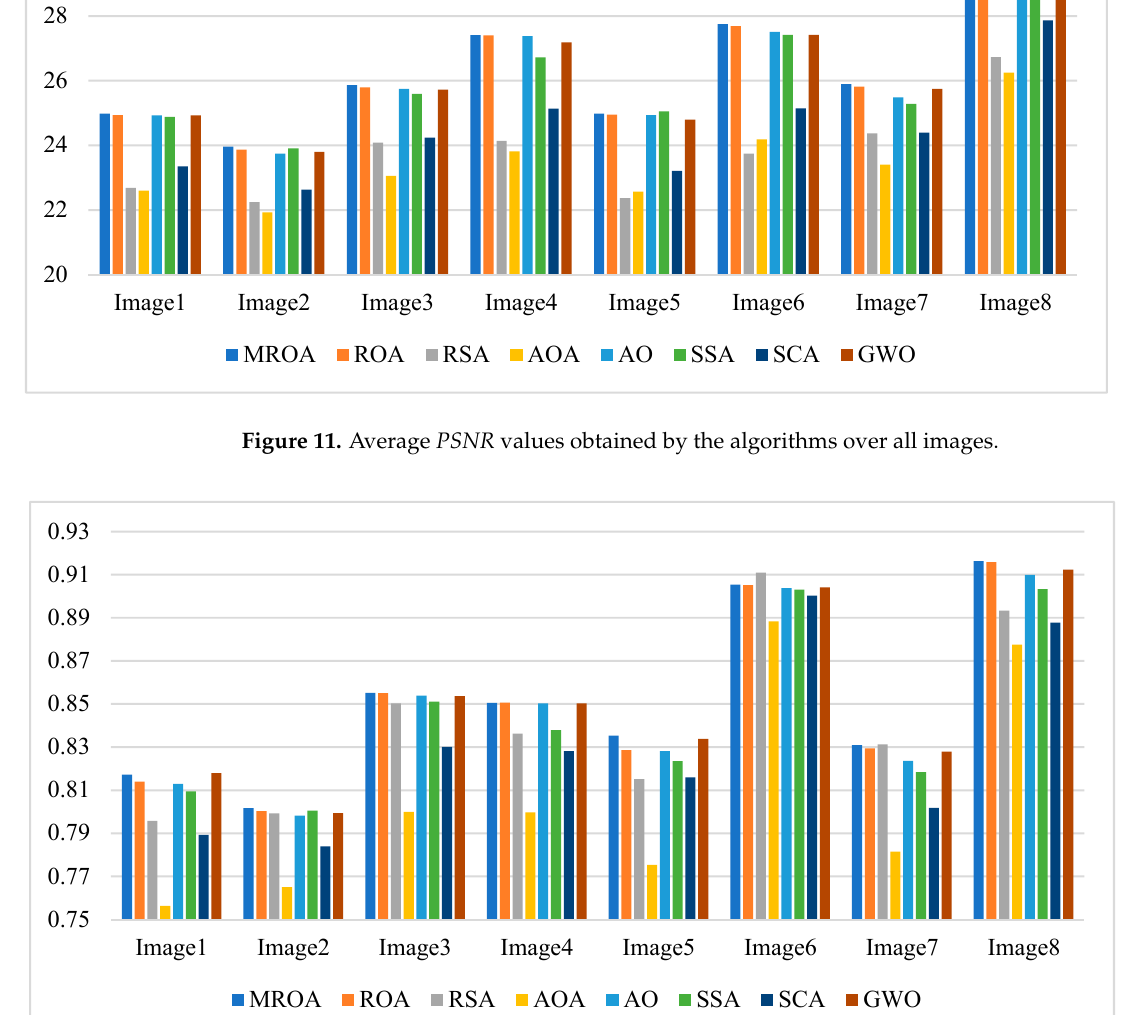
Figure 12. Average SSIM values obtained by the algorithms over all images.